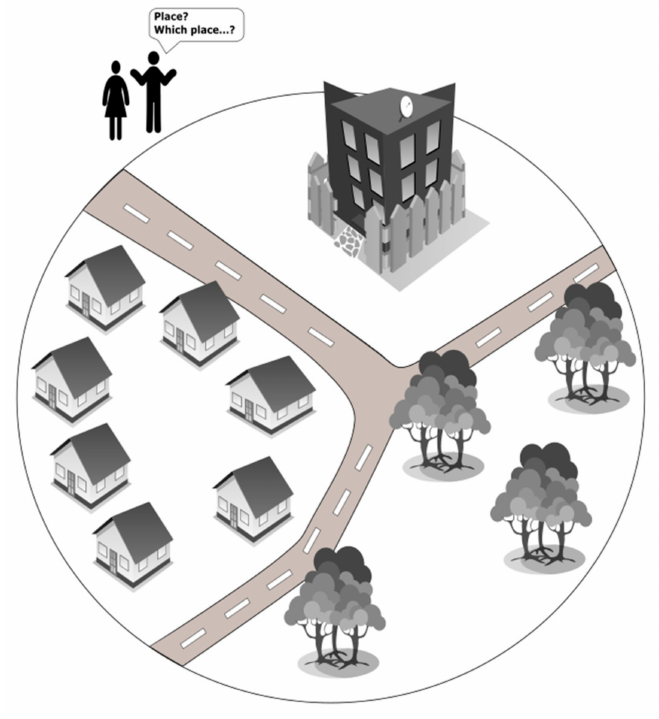
Figure 2. “Place, which